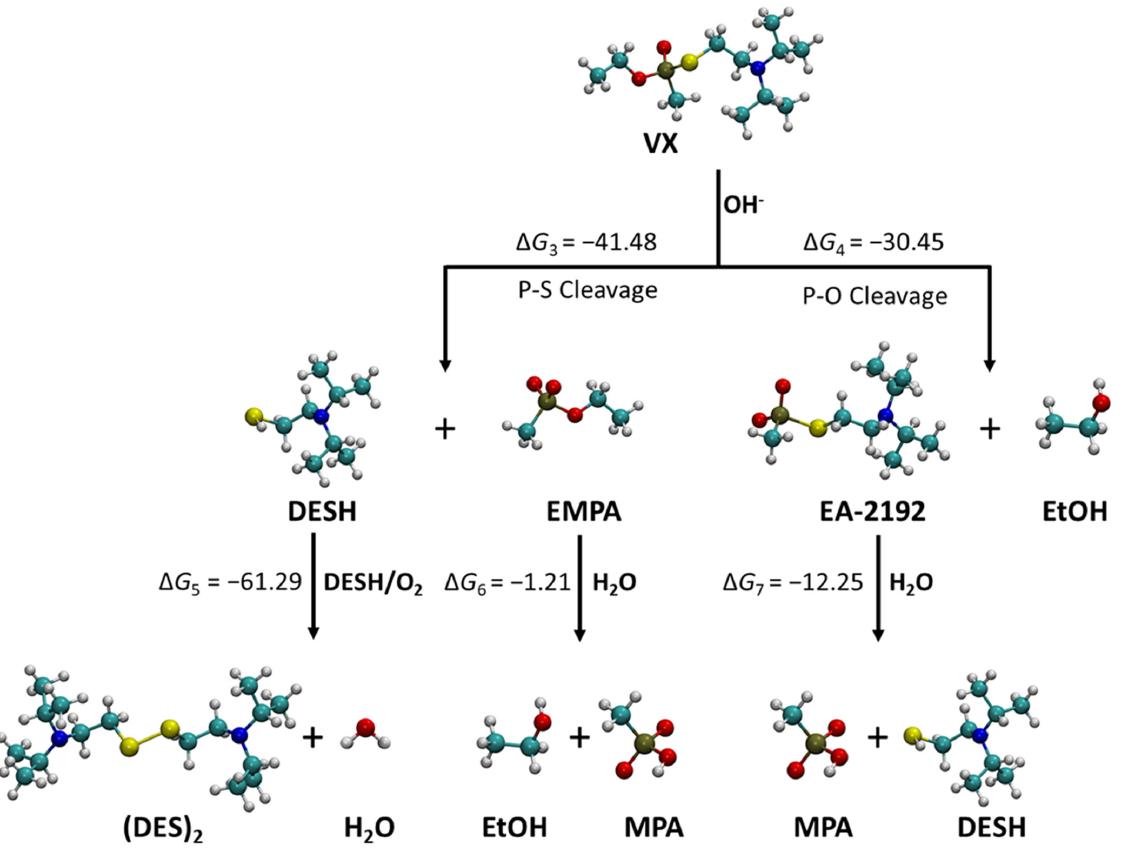
Figure 3. Full aqueous neutralization pathway for VX starting with an initial alkaline hydrolysis step.